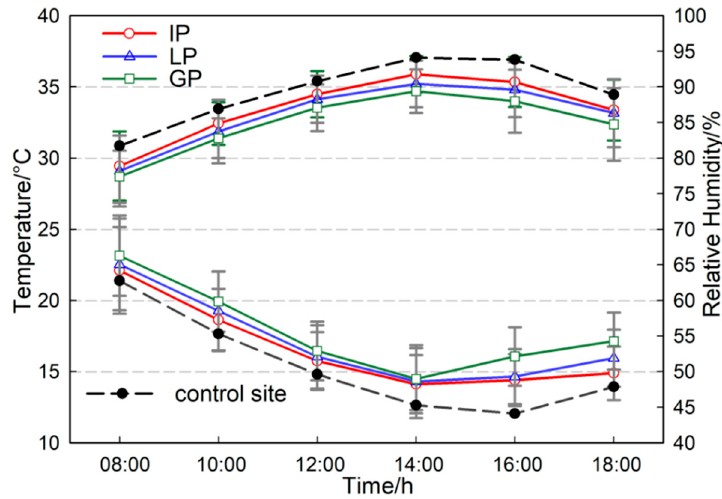
Figure 4. Diurnal variations of air temperature and relative humidity during the experimental